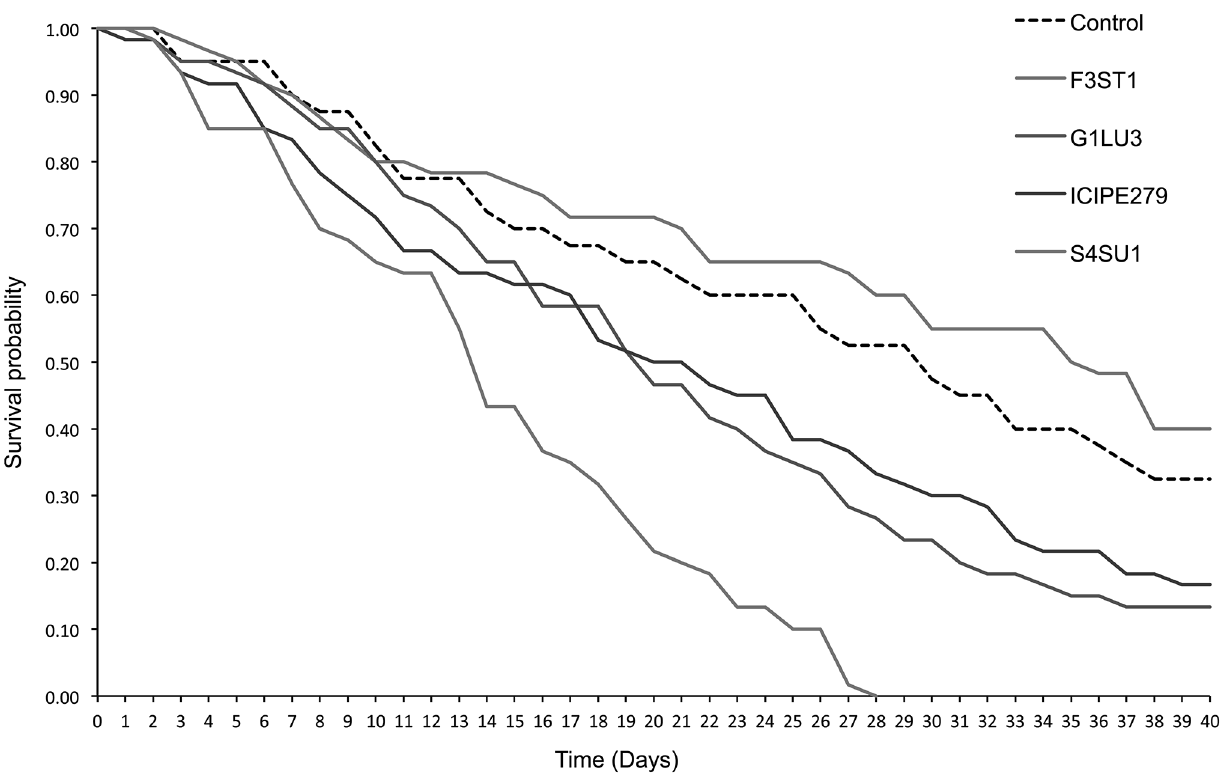
Figure 8. Progeny survival curves of Phaedrotomascabriventris emerging from Viciafaba plants endophytically-colonized by different fungal isolates of Beauveriabassiana (S4SU1, G1LU3 and ICIPE279) and Hypocrealixii (F3ST1) and infested with 2 nd and 3 rd instar larvae of Liriomyzahuidobrensis .